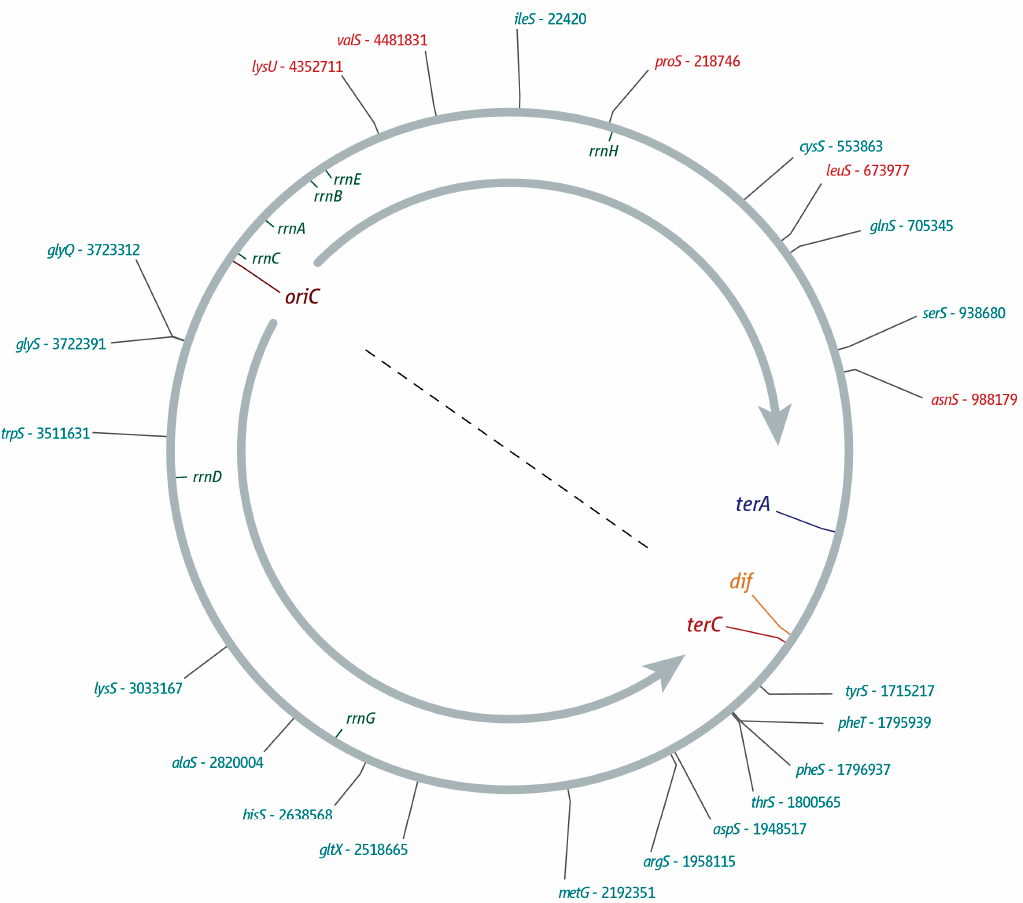
Figure 4. Location and orientation of genes coding for aminocyl tRNA synthetases within the E. coli chromosome. oriC , the innermost ter sites, and the dif chromosome resolution site as well as locations of rrn operons A–E , G , and H are indicated. Orientation of replication within a replichore is indicated by a grey arrow. Locations of genes encoding aminoacyl tRNA synthetases are indicated on the outside. Genes transcribed co ‐ directionally with replication are shown in cyan, genes transcribed in head ‐ on orientation relative to replication in the replichore are shown in red.